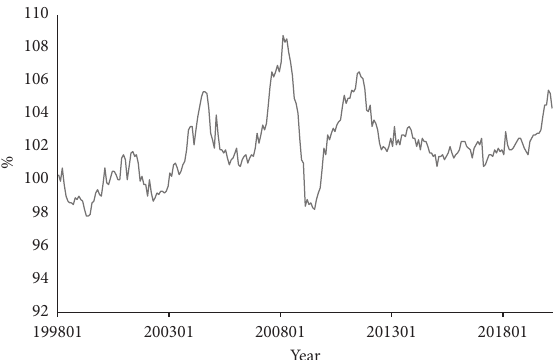
Figure 1: Historical data map of CPI in China.